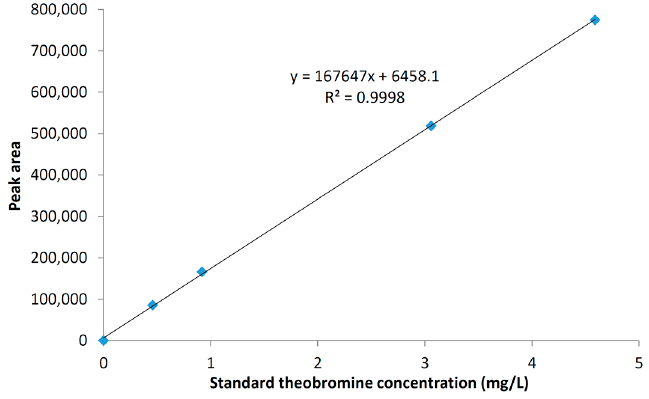
Figure 3. Calibration curve of standard theobromine.